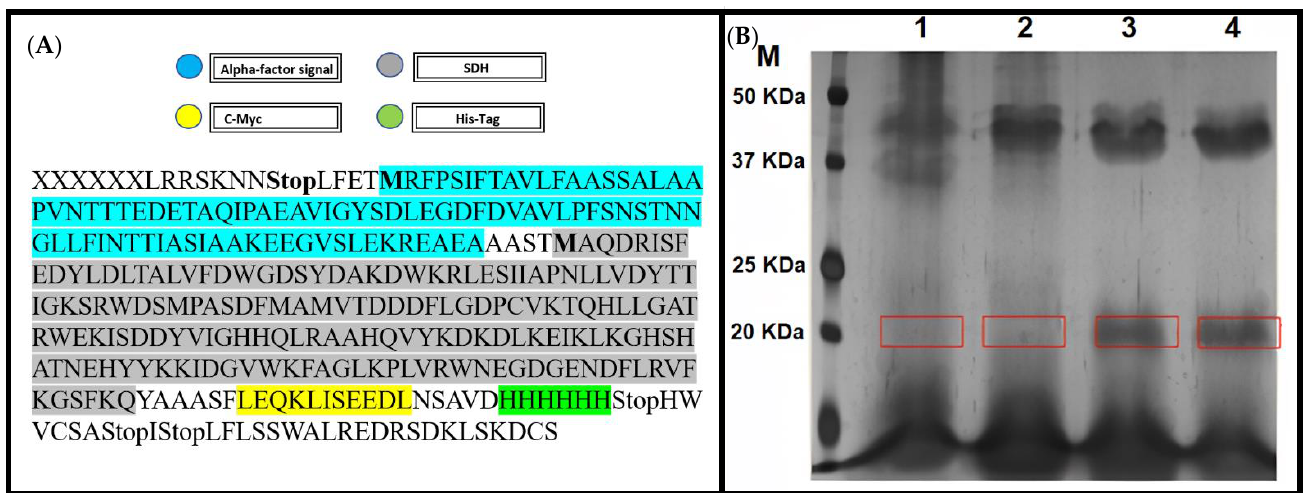
Figure 5. SDH S. cepivorum expression. ( A ) Scytalone dehydratase ORF, a protein with 167 amino acids and a tail of six histidines and C-Myc = cutting site. ( B ) SDH expression 1: P. pastoris wt; 2: P. pastoris with empty vector; 3 and 4: P. pastoris with SDH gene vector. SDH = 22.61 kDa (SDS-PAGE 12%, Coomassie staining).